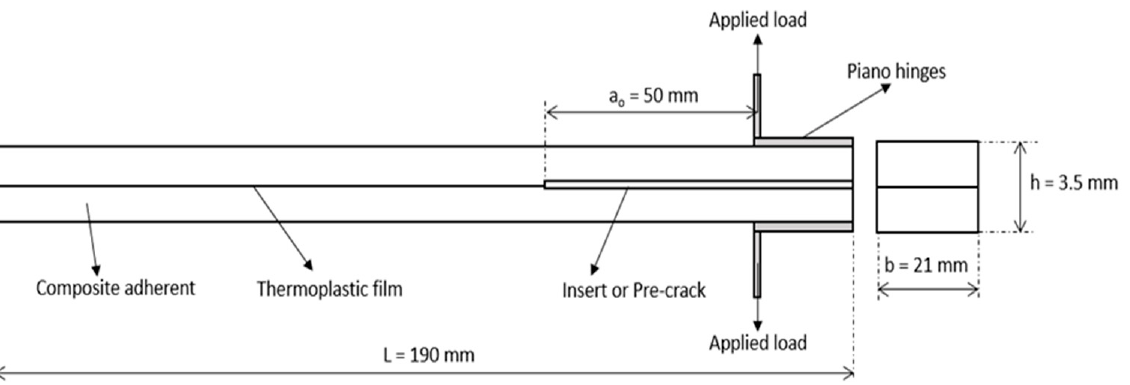
Figure 4. Schematic of DCB specimen.